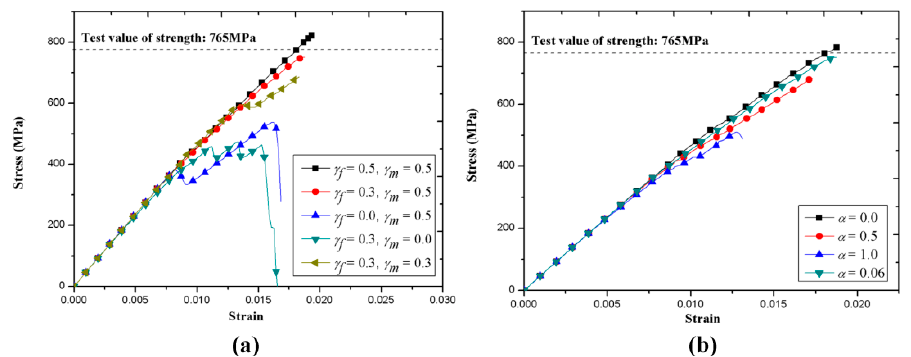
Figure 8. Numerical predicted stress-stain responses of notched tension specimen with: ( a ) different damage thresholds and ( b ) different shear failure coefficients.